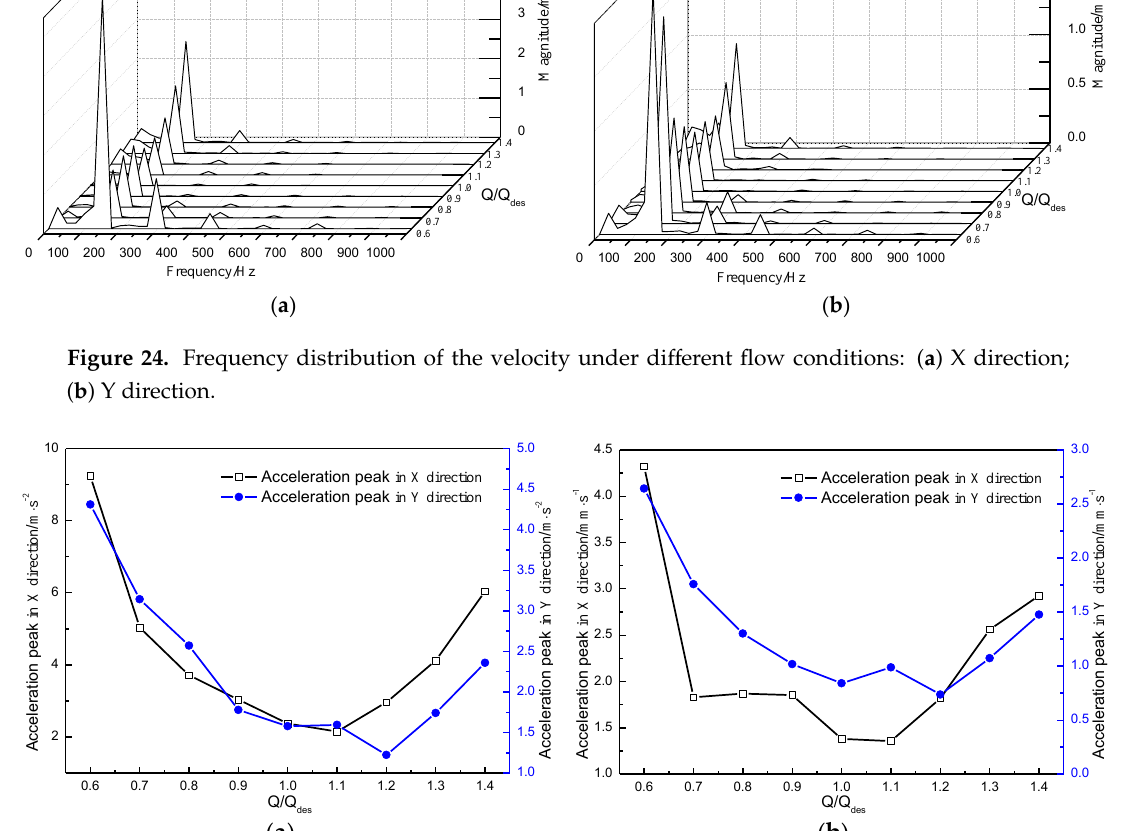
Figure 25. Comparisons of the vibration indicators under different flow conditions: ( a ) Acceleration